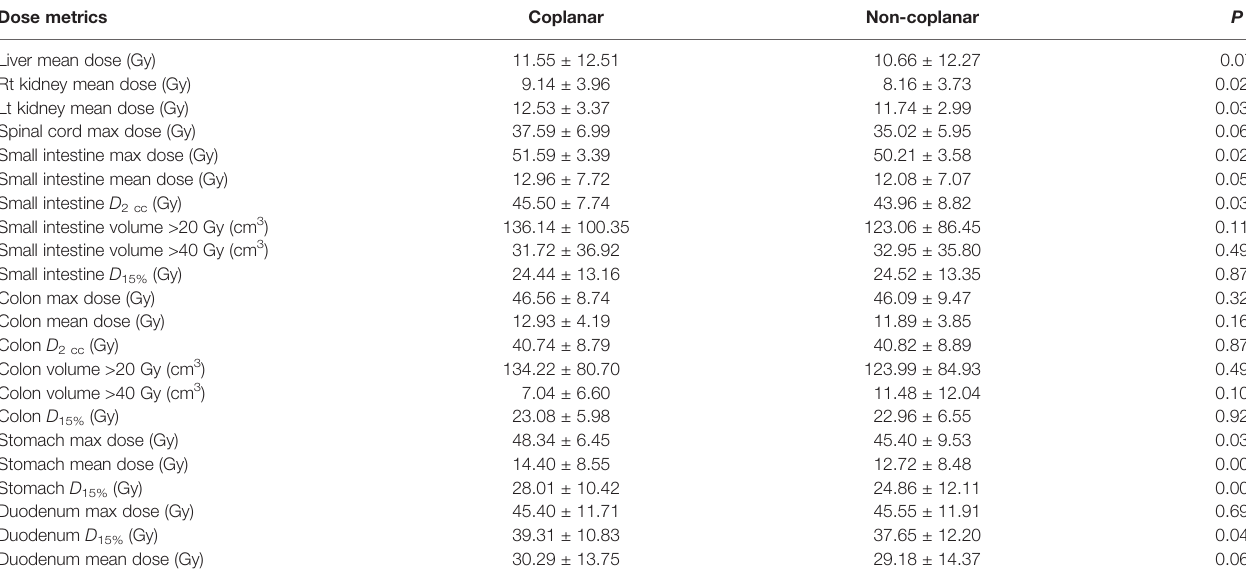
TABLE 3 | Normal tissue dose – volume statistics. Dose